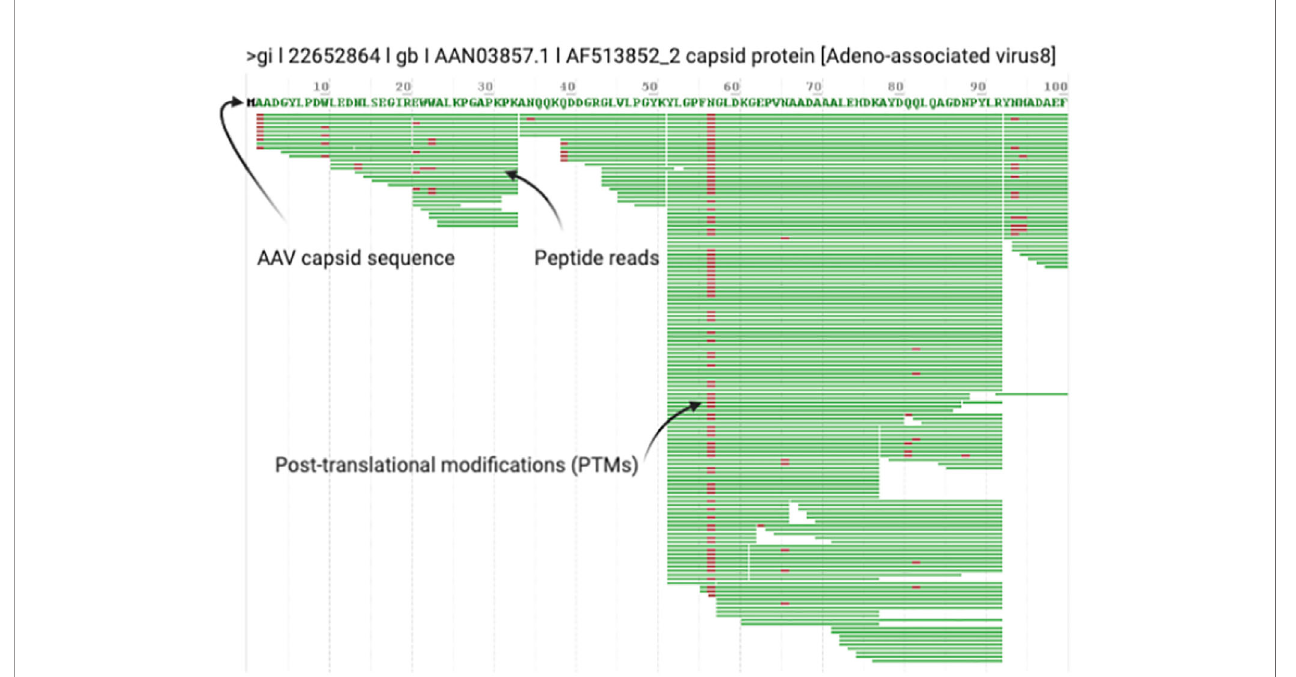
FIGURE 2 | Example Digestion Ef fi ciency Validation. Trypsin cleaves peptides on the C-terminal side of lysine and arginine residues (unless followed by a proline). All rAAV capsid serotypes have regular Lys and Arg amino acids throughout VP1 so you should see regular cleavage that produces peptides ~10-45 amino acids in length (shown in Preview as green bars with PTMs noted in red) throughout the entire length of VP1. Good digestion ef fi ciency and MS/MS runs should exhibit >90% sequence coverage of rAAV VP1. This screenshot highlights typical results for the fi rst 100 amino acids of a prototypical rAAV8